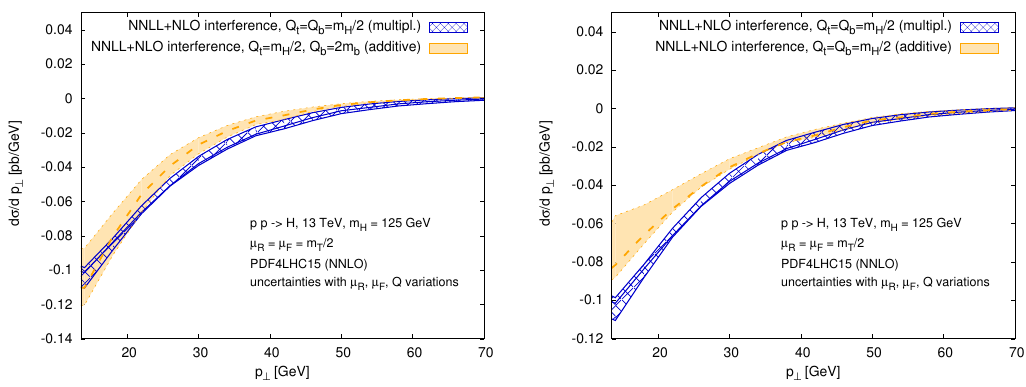
Figure 3 . Comparison between the additive scheme with Q t = m H = 2, Q b = 2 m b (left plot) or Q t = Q b = m H = 2 (right plot), and the default multiplicative scheme with Q t = Q b = m H = 2.